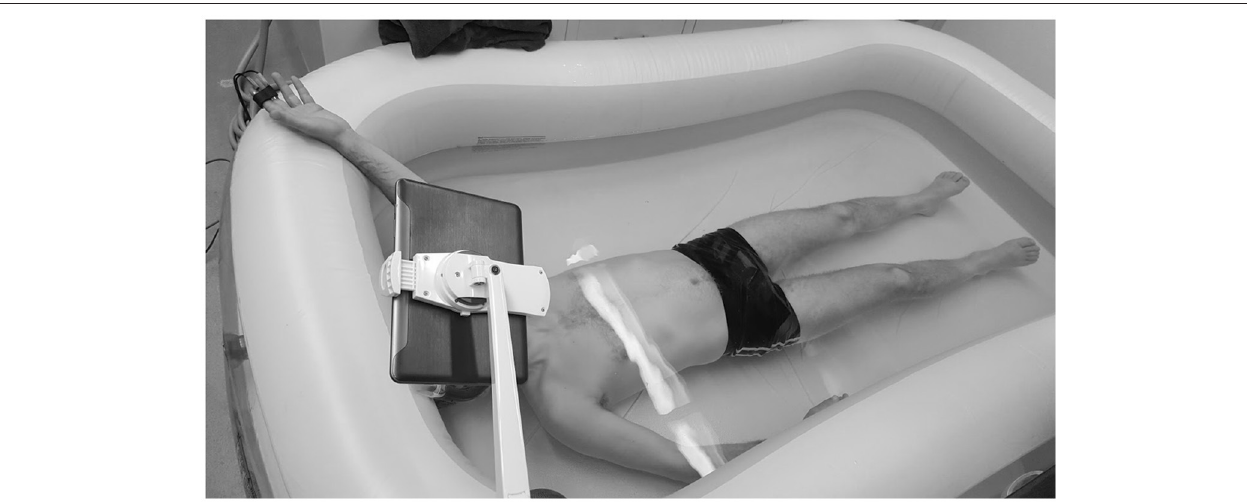
FIGURE 1 | Experimental setup. EDA data was collected in the middle and index fingers on left hand, while subjects underwent Stroop test underwater. Written informed consent was obtained from the individual for the publication of this image. Values are expressed as mean ± standard